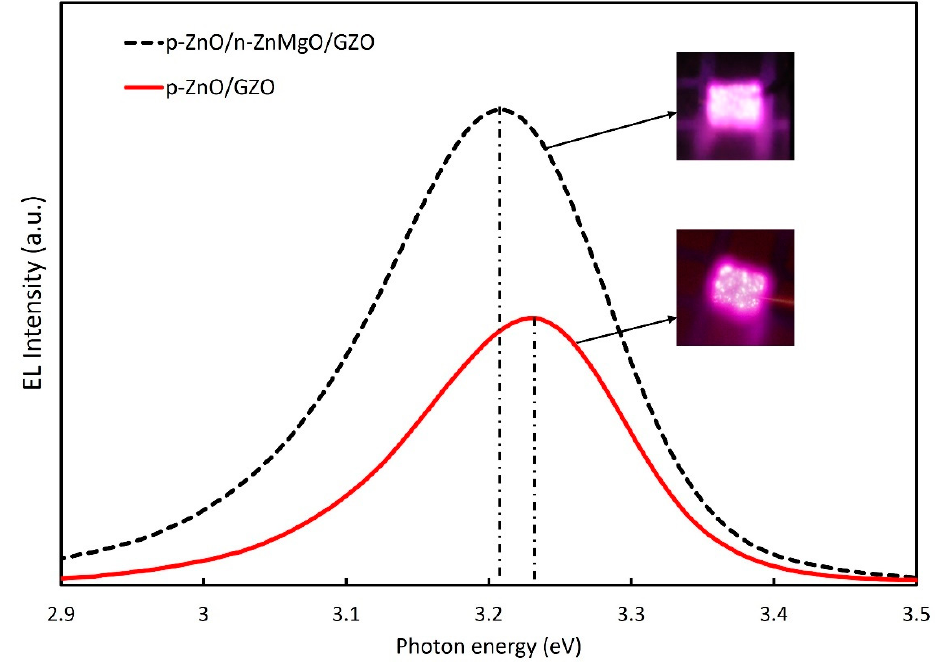
Figure 7. EL comparison for ZnO NP LEDs with the of p-ZnO/n-ZnMgO/GZO and p-ZnO/GZO structures at an injection current of 12 mA and the applied voltages were 5.0 V and 3.0 V, respec- tively.